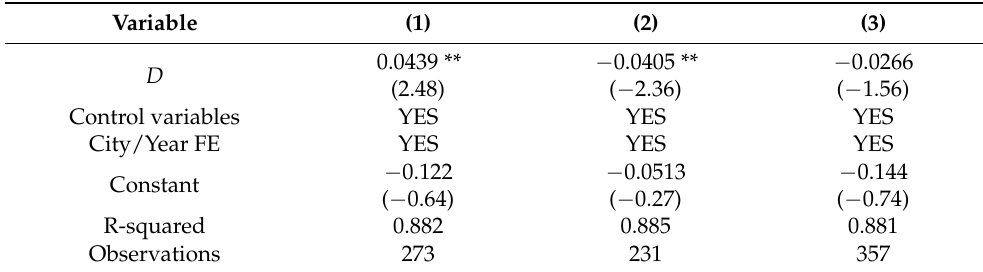
Table 6. Heterogeneity of effects in different